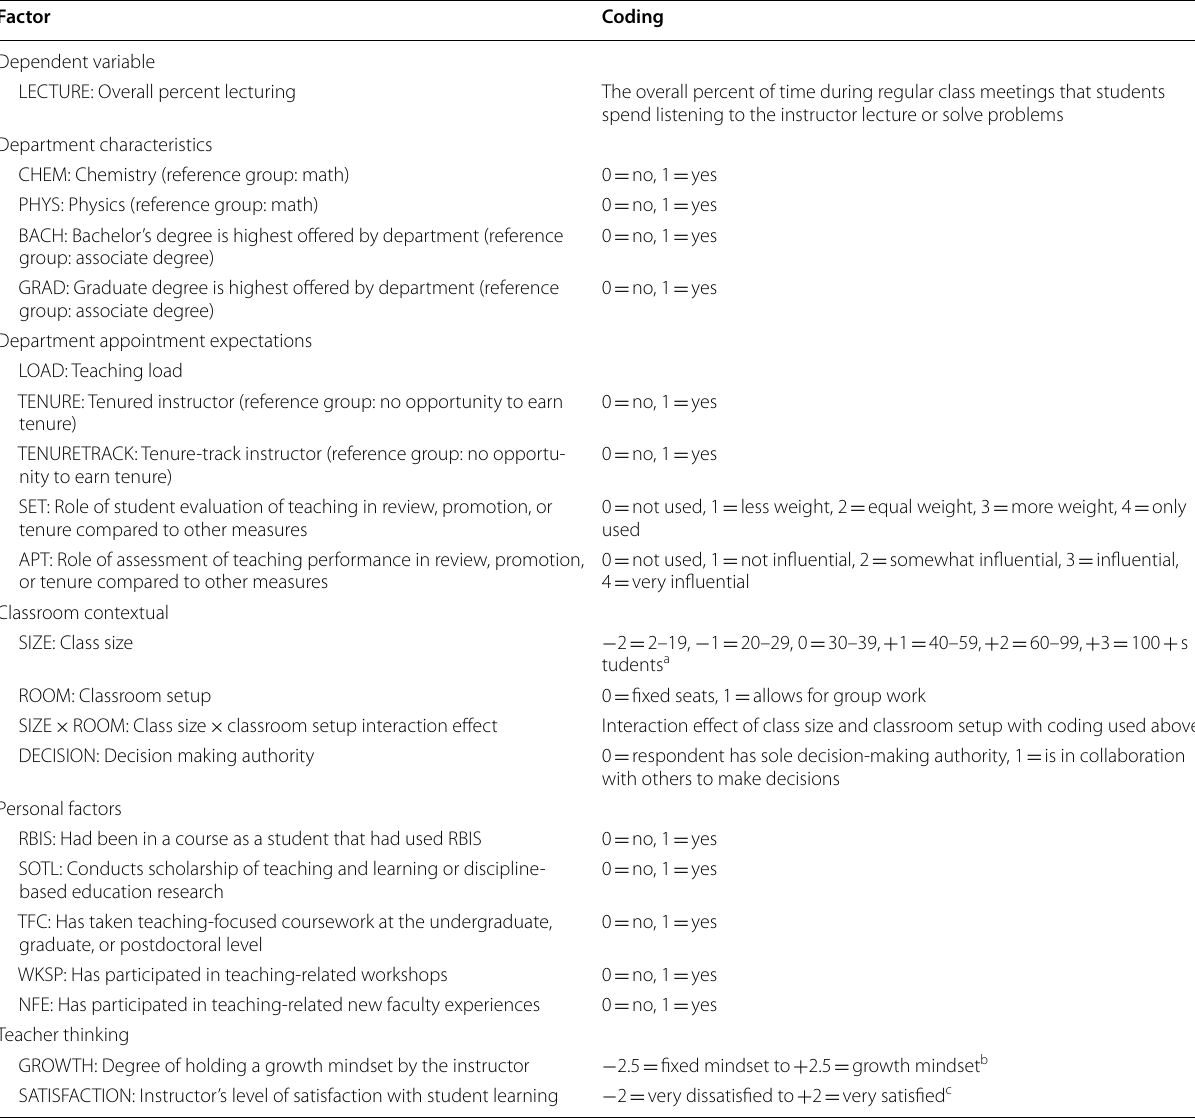
Table 1 Factors used in the final multilevel model and their coding